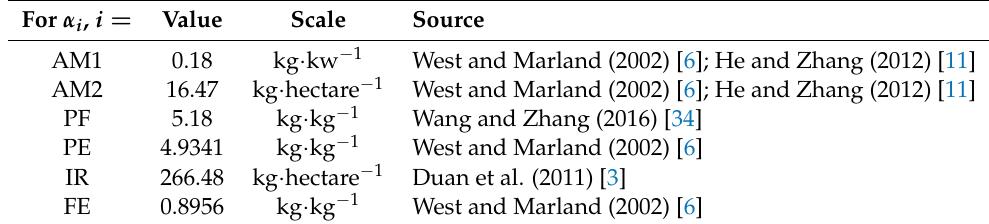
Table 3. The carbon emission